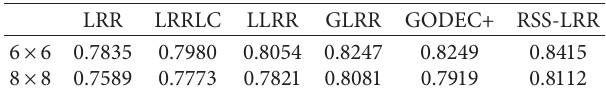
Table 6: Classification accuracies on CMU PIE under 6 × 6 and 8 × 8